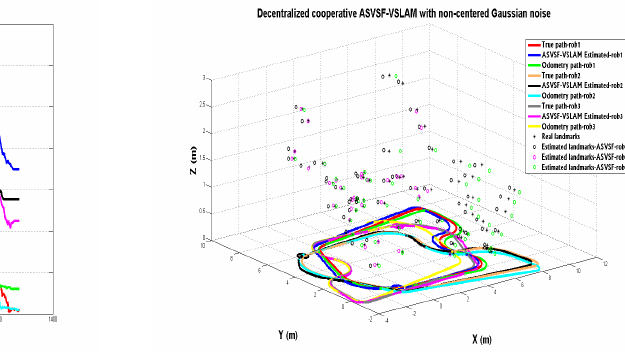
Fig. 9: Visual ASVSF-SLAM simulation results with non-centered Gaussian noise.